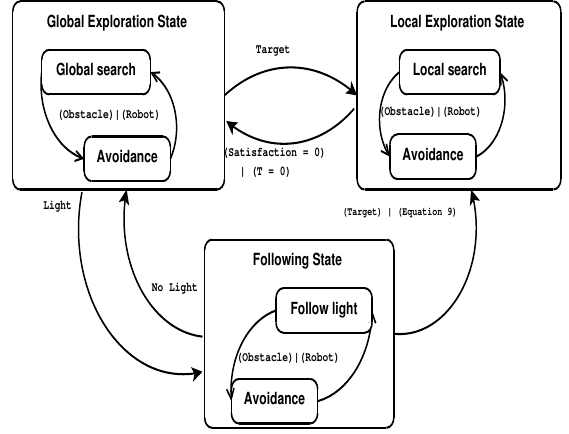
Figure 2. FSM of LFA Robots, where T is the time fixed for exploitation.